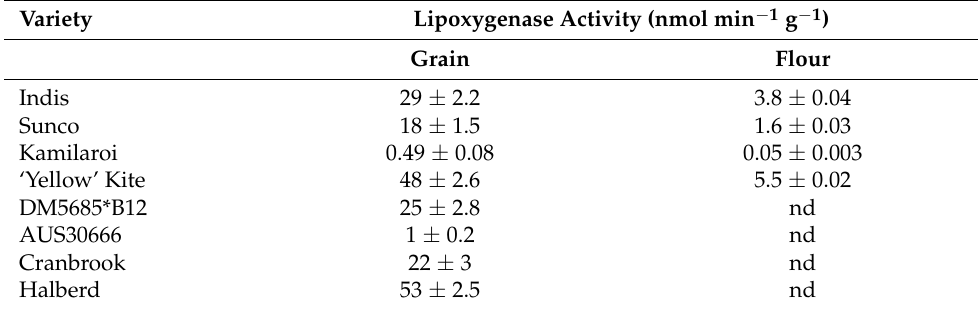
Table 2. Lipoxygenase activity in grain and flour of wheat varieties. nd = not determined.